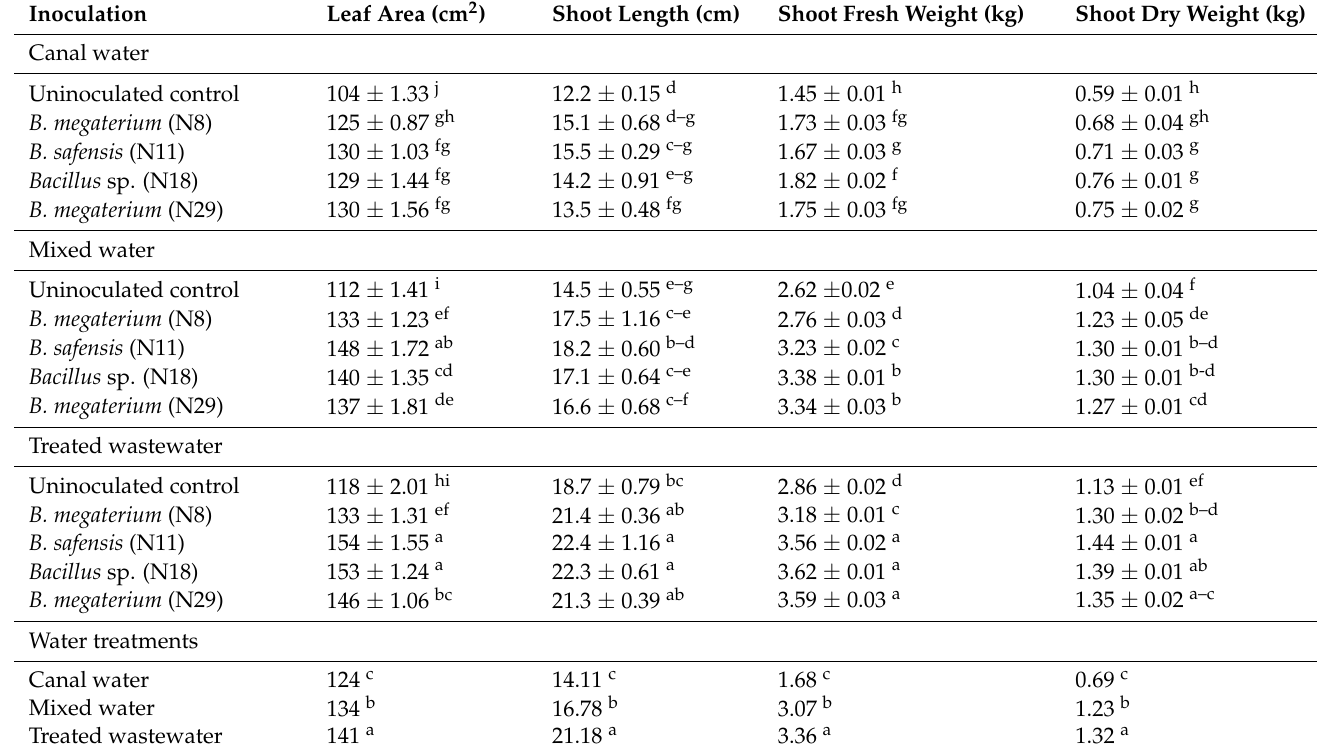
Table 3. Effect of Pb-tolerant Bacillus strains on the root growth of spinach plants under treated wastewater, mixed water, and canal water treatment.